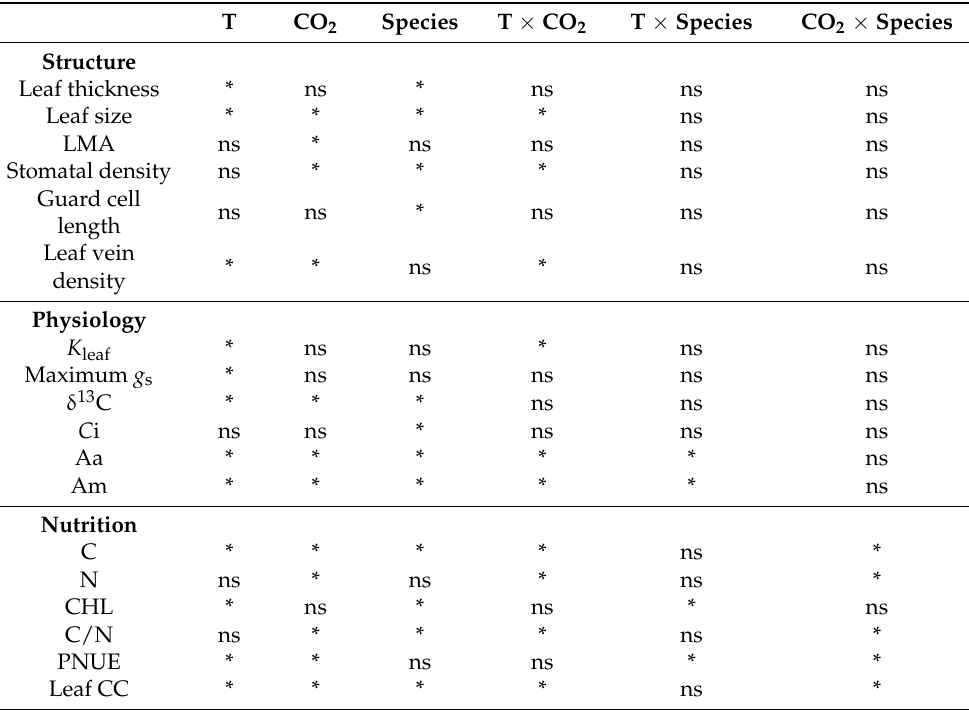
Table 1. The three-way-ANOVA results showing the effects of [CO 2 ], temperature (T), species, and their interactions on all the structural and physiological